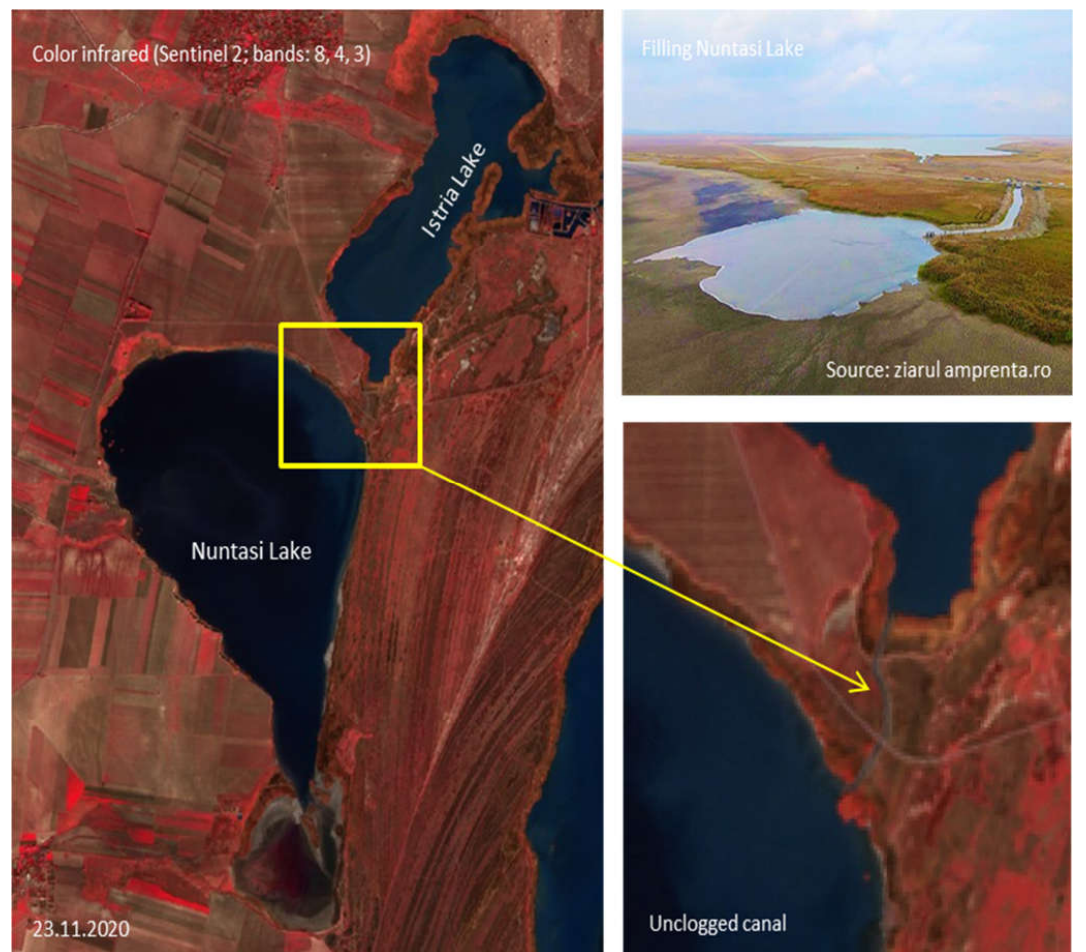
Figure 8. Nuntași and Tuzla Lakes after refilling process. Figure 8. Nuntas i and Tuzla Lakes after refilling ,